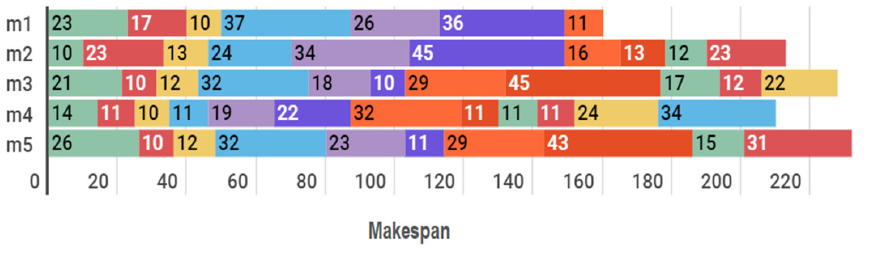
Fig. 5. Gantt chart of solution makespan in the first scenario o Results of the second